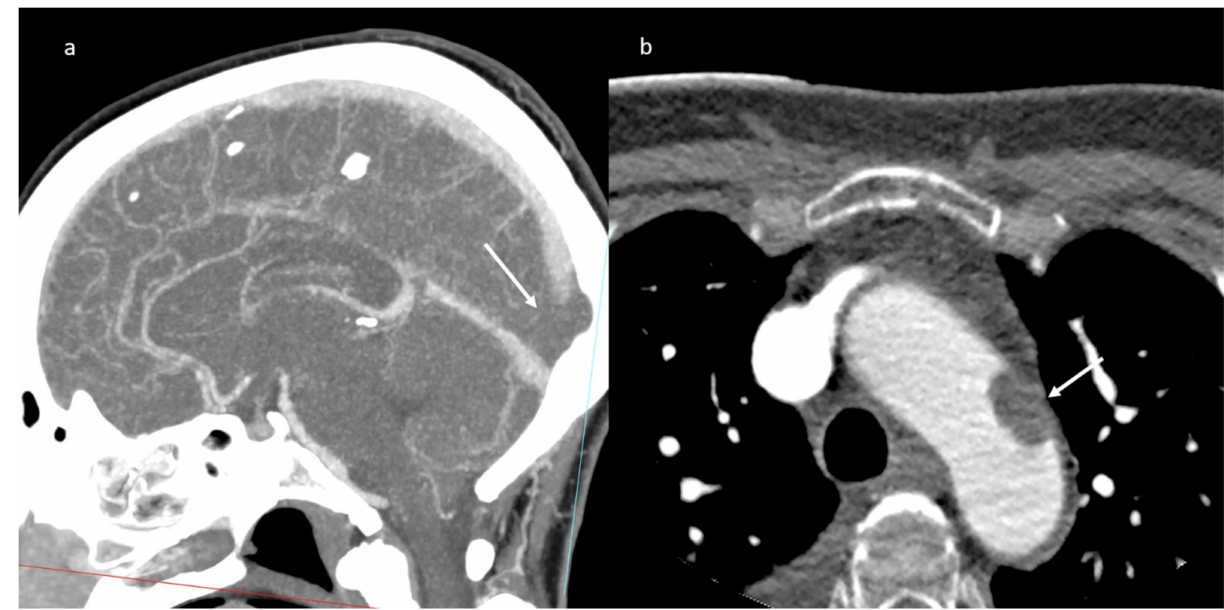
Figure 2. CT-angiography: partial thrombosis of the vein of Galen ( a ); presence of a floating thrombus within the aortic arch ( b ). The patient was transferred to the Hemodynamics room at 1.00 p.m. a plain old balloon angioplasty (POBA) of the right coronary artery was performed, without stent implantation, with restoration of distal flow, but with persistence of extensive thrombosis of the vessel (Figure 3) with a theoretic indication for administration of intracoronary antiplatelet agents (Aggrastat). However, given the hematological and neurological status, such therapy was not performed. A progressive worsening of the neurological state was observed until a comatose status (GCS 6) started during the procedure. The patient was transferred to the Intensive Care Unit.